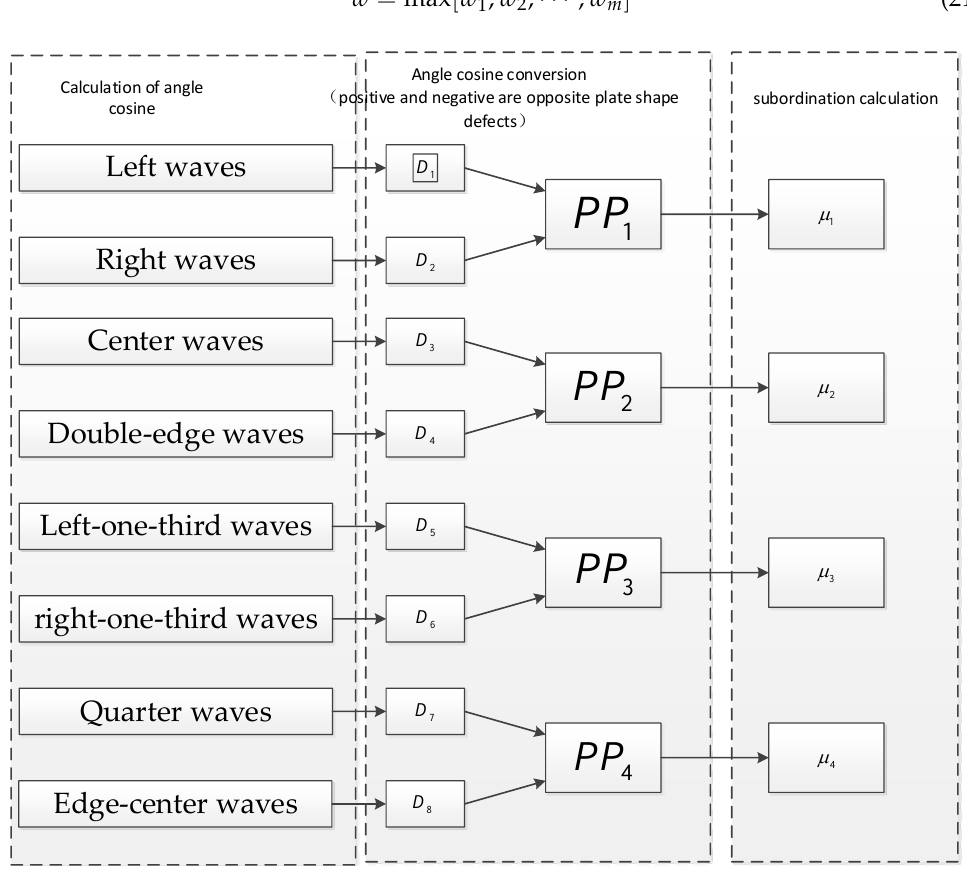
Figure 7. The flow chart of flatness pattern recognition calculation. ( PP k is is the result of calculating two mutually inverted flatness defects according to equation (19), k = 1,2,3,4)